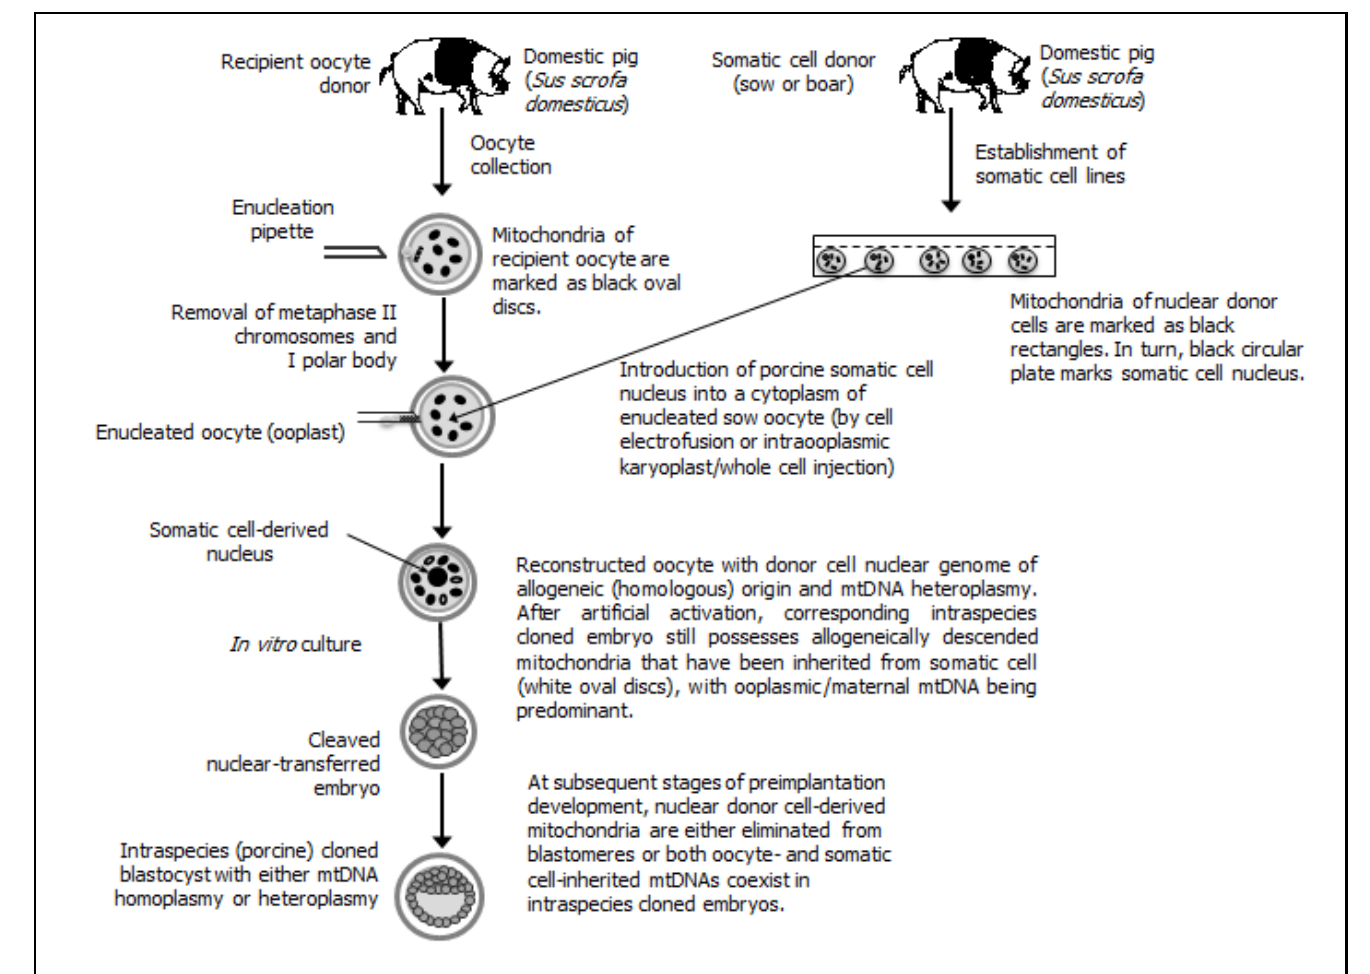
Figure 1. Intraspecies somatic cell cloning, in which the inheritance of allogeneic (homologous) mtDNAs stemming from genetically different nuclear recipient oocytes and nuclear donor cells is still incompletely recognized during preimplantation development of nuclear-transferred pig embryos. In the vast majority of intraspecies (porcine) cloned embryos, mitochondrial genome primarily arises from the nuclear recipient oocytes, whereas in their other counterparts, mtDNA copies appear to be inherited heteroplasmically (i.e., both from nuclear donor cells and from recipient